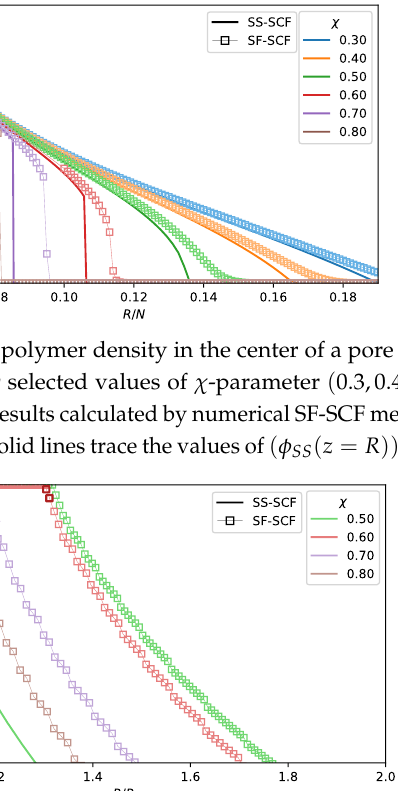
Figure 10. Polymer brush thickness min { H , R } in a poor solvent as a function of the normalised pore radius R / R opening calculated using the numerical SF-SCF method (squares) and within analytical SS-SCF approximation (solid lines) for selected values of χ parameter, ( 0.50;0.60;0.70;0.80 ) for N = 1000, σ = 0.02. Here, R opening is the minimal open pore radius calculated within analytical SS-SCF approximation. Note the jumps (darkened color arrows) for χ = 0.8 and χ = 0.7 between close sequential calculations with varied R ; the upper darkened marker on a scatter correspond to the closed pore H / R = 1, while the lower darkened marker correspond to open pores with brush height H < 0.95 R for χ =